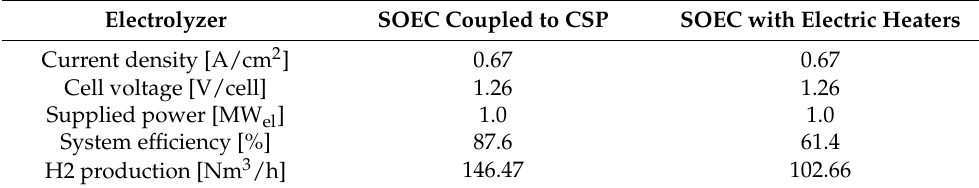
Table 3. Electrolyzers’ operational metrics